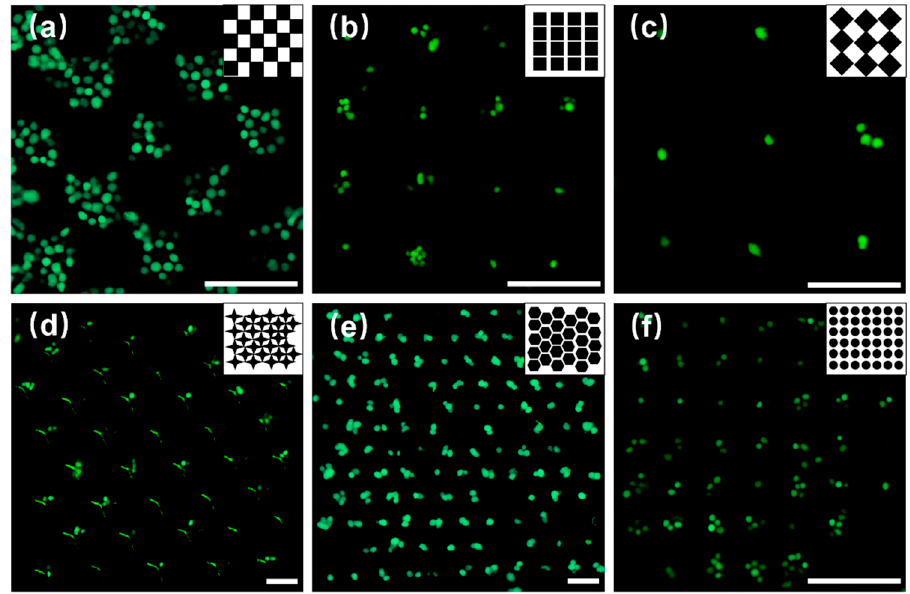
Figure 6. Breast cancer cells captured by microwell arrays with different shapes. ( a ) Chessboard, ( b ) Rectangular, ( c ) Diamond, ( d ) Four-angle star, ( e ) Honeycomb, and ( f ) Circular. Scale bar: 150 μ m.